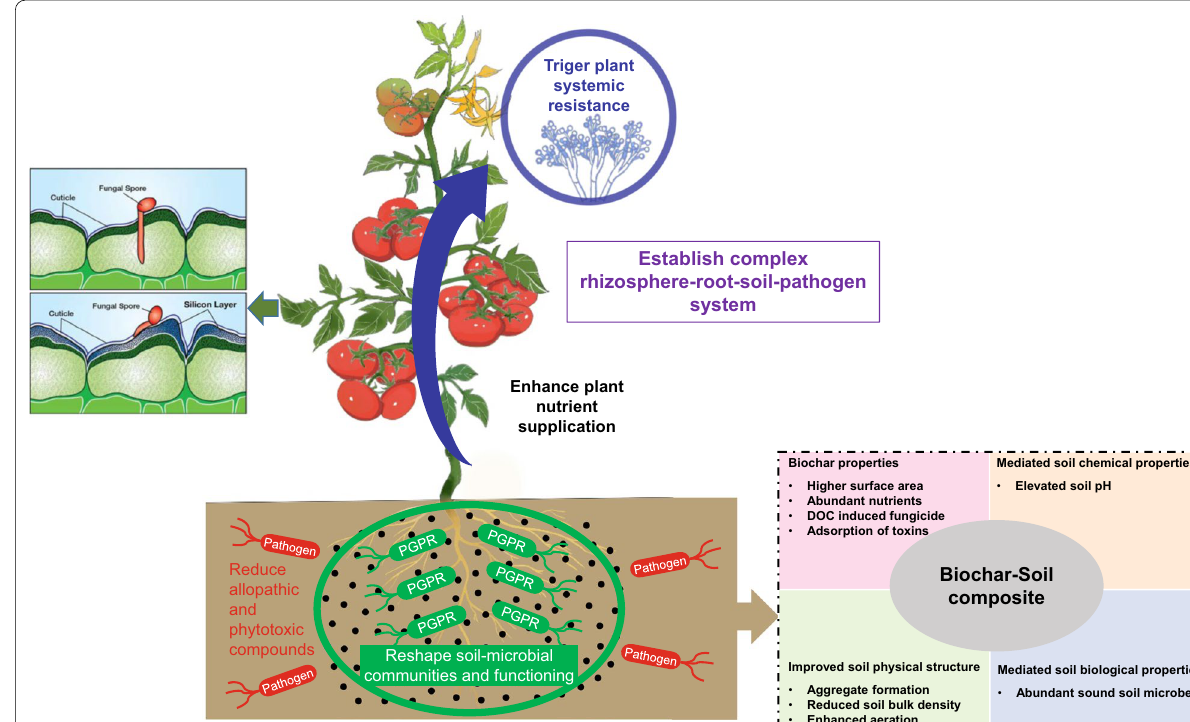
Fig. 4 Scheme of biochar application for plant disease suppression in the root and shoot parts. (part of the figure is adapt from https:// www. onhyd ropon ics. com/ index. php/ en/ 74- news- nutri ents- en/ 99- silic on- suppl ement ation-